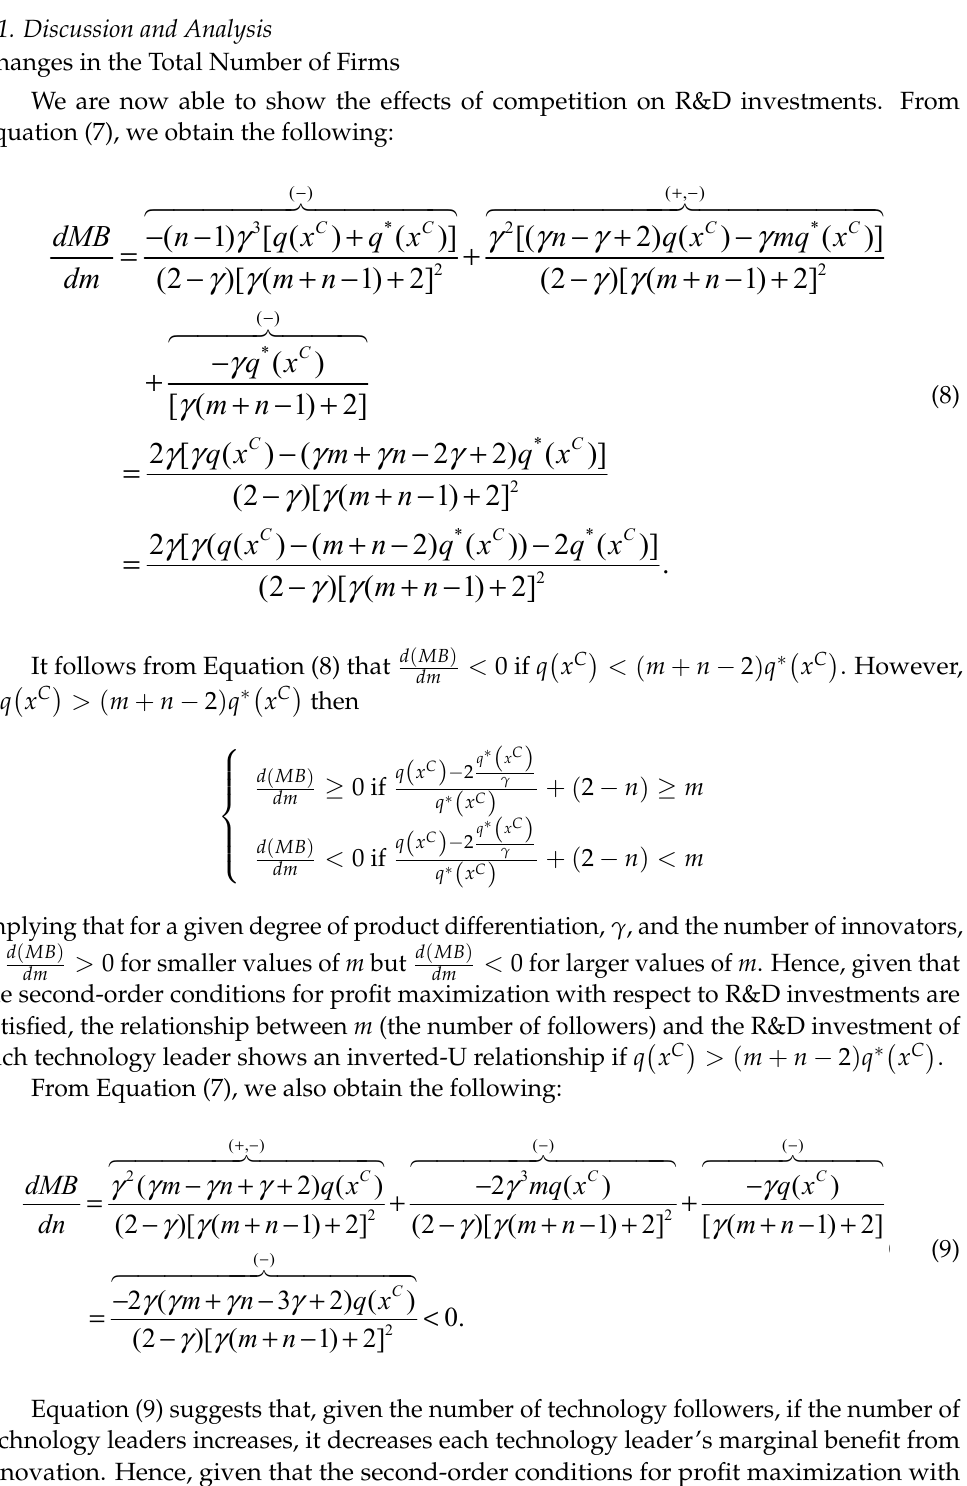
Table 1. The impact of the number of firms on individual R&D investment. Strategic Effect on